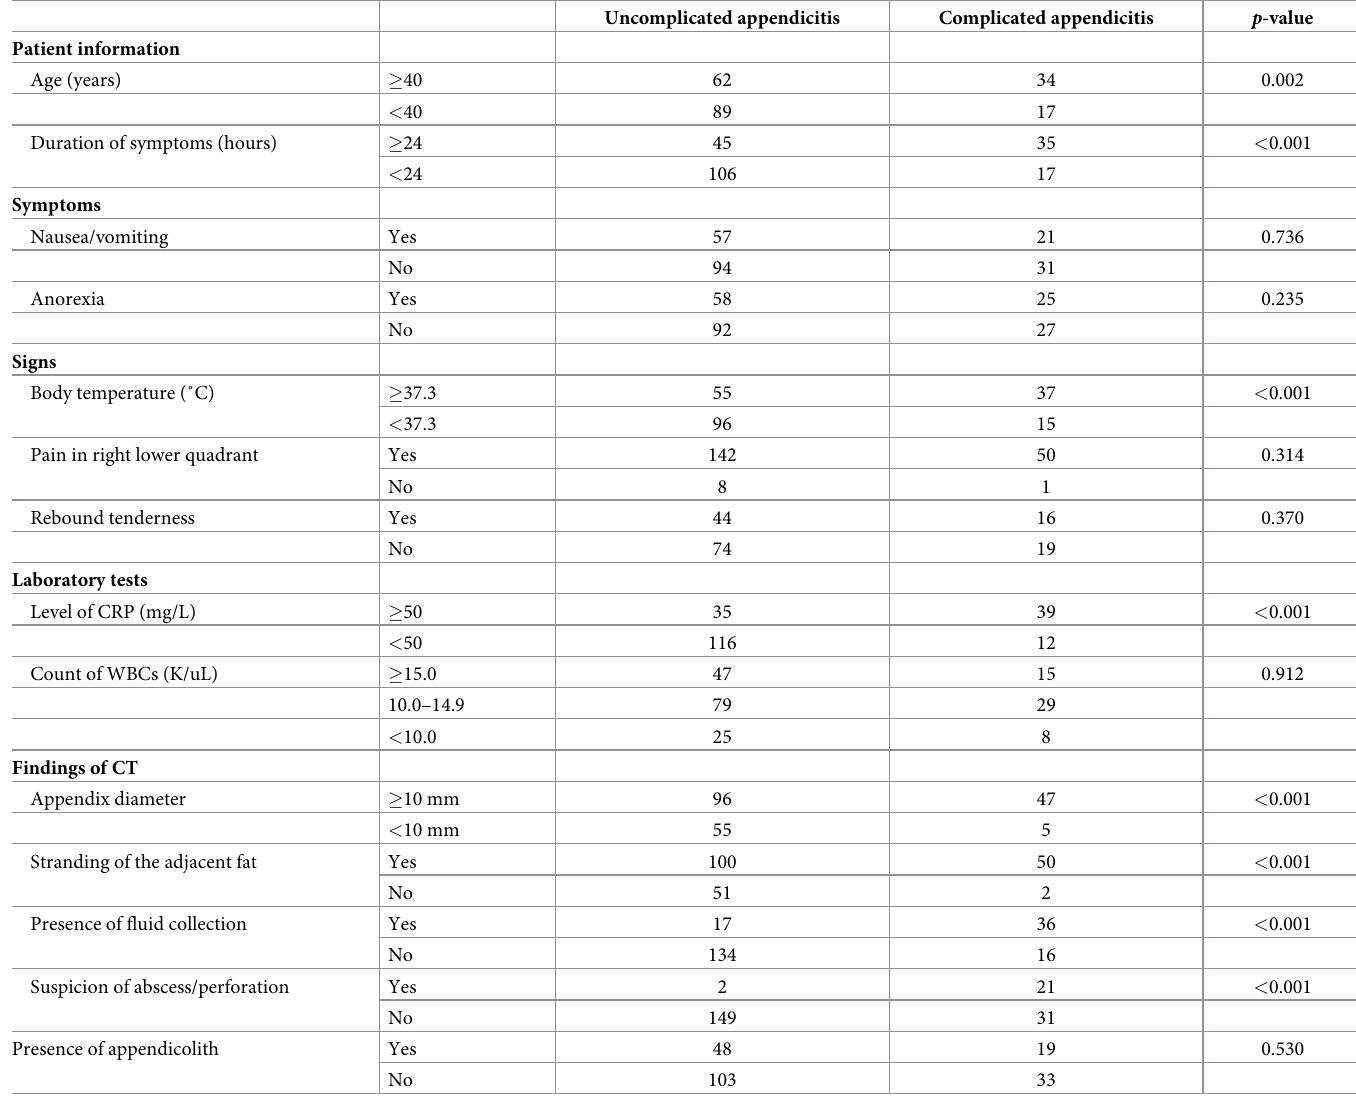
Table 2. Comparison of preoperative factors between uncomplicated and complicated appendicitis